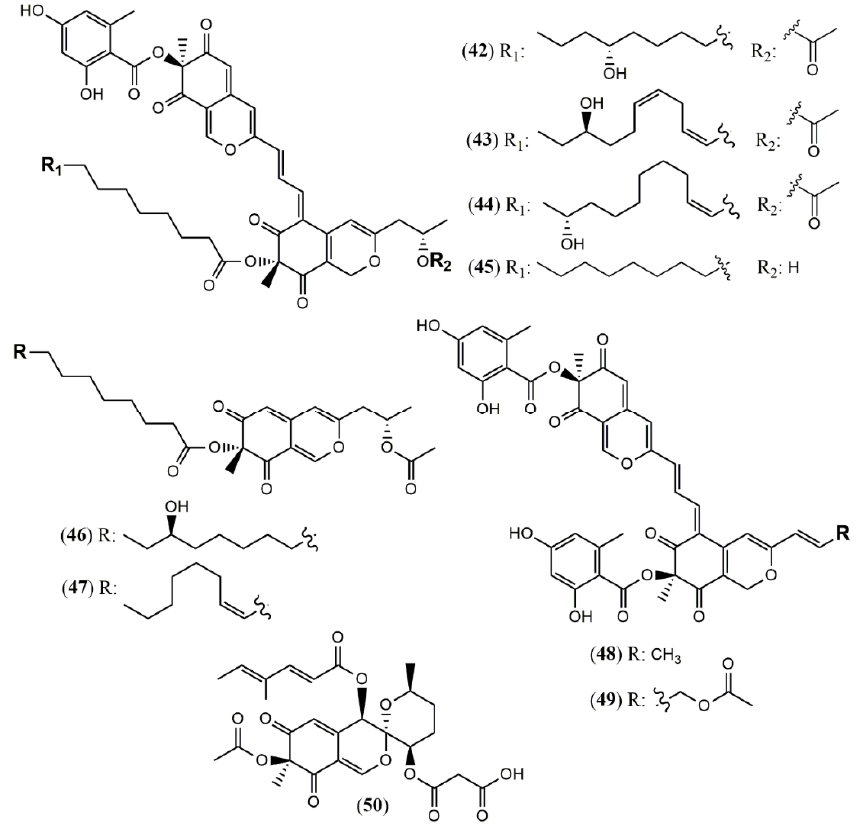
Figure 4. Chemical structures of Hypoxylon azaphilones: 42–45 : hybridorubrins A–D; 46–47 : fragi- rubrins F and G; 48–49 : rutilins C–D; 50 : 3’-malonyl-daldinin F